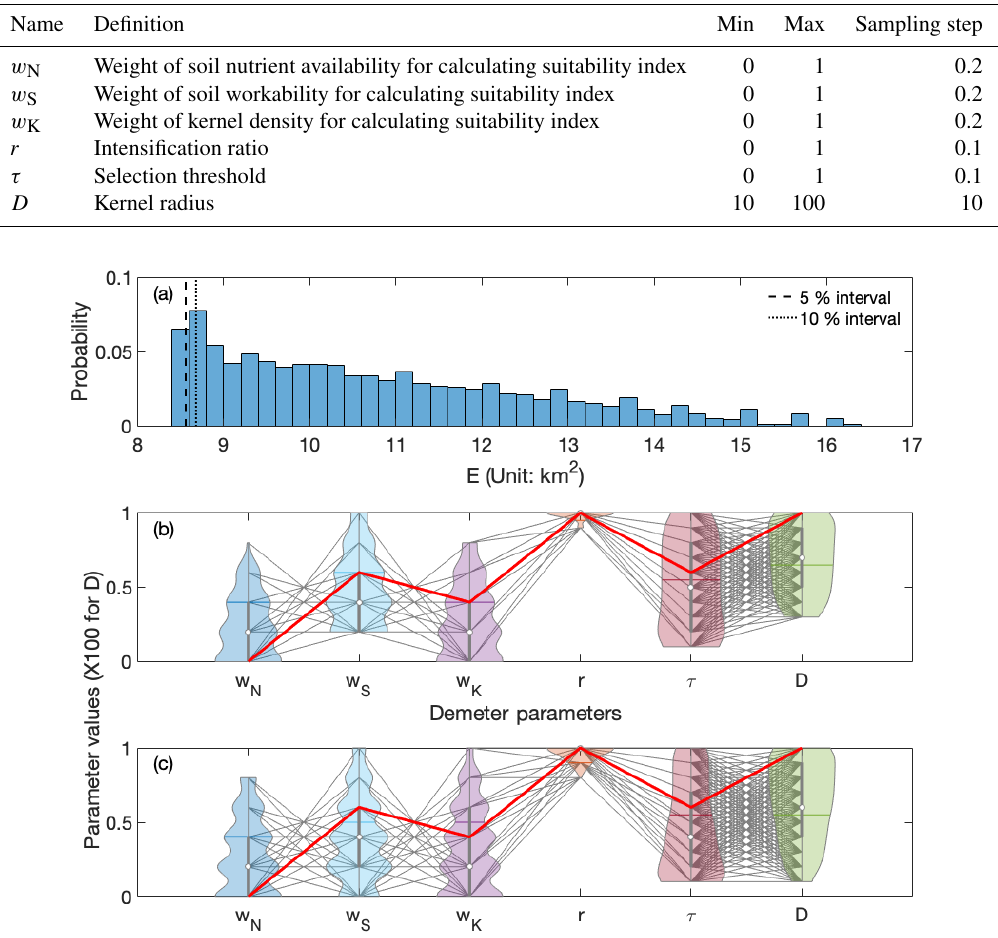
Figure 2. (a) Histogram of E values, i.e., the global average discrepancies between the downscaled and observed land cover areas with the 23100 ensemble parameter sets; the vertical dashed line in (a) shows the interval of the “acceptable” 5% parameters, as described in Sect. 2.3. (b) The probability density of each of the acceptable 5% parameters, as shown by the violin plots; the black lines across the six parameters show all the acceptable 5% parameter sets, and the red line indicates the global optimal parameter values; the box plots and horizontal bar inside the violin plots indicate the interquartile ranges and the mean of the parameter values, respectively. (c) Same as (b) but showing the “best” 10% parameter sets. Note that the values of D were divided by 100 for the purpose of illustration in (b) and (c)